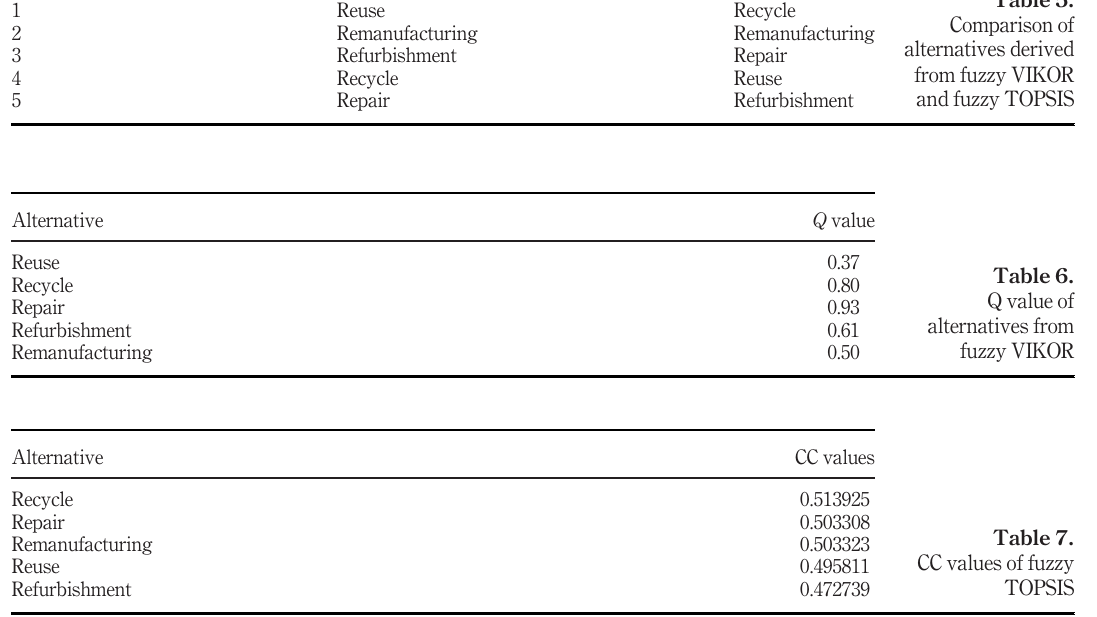
Table 5. Comparison of